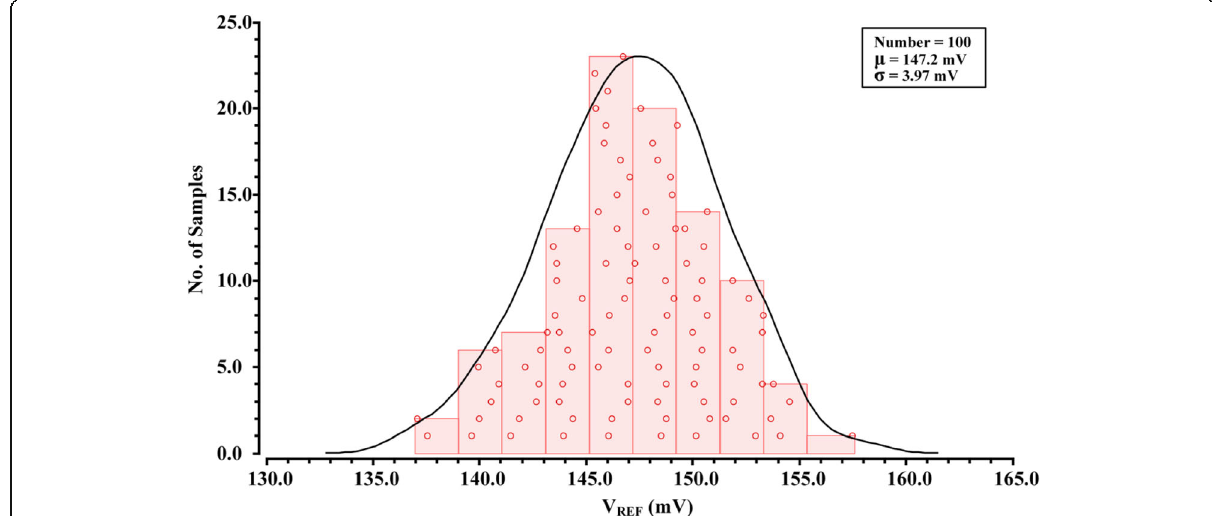
Fig. 9 Distributions of untrimmed V